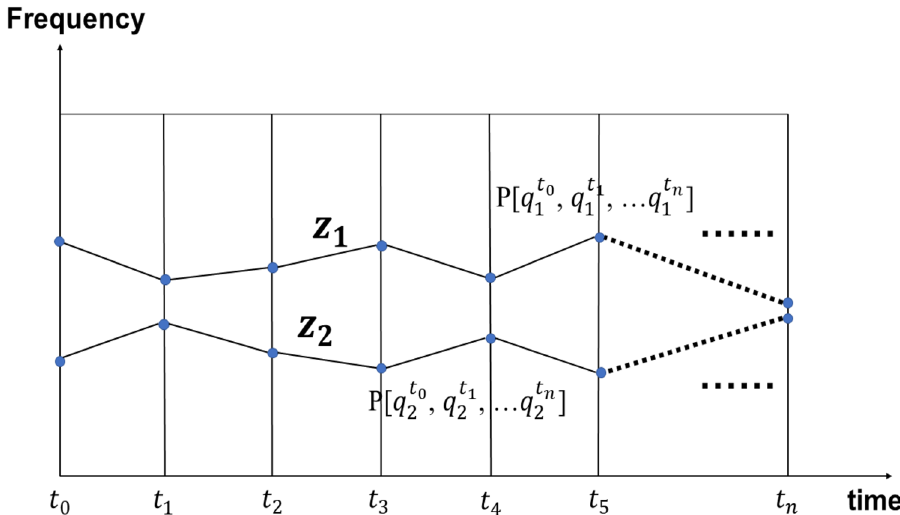
( t ) 1,2 ] whose independent variable is a time ( t ) 1,2 ,]. For the discrete case, the distribution of the probability ] . The path distribution is satisfied q ( t ) + q ( t ) P path [ q ( t 0 ) q ( t 1 ) q ( t 2 ) q ( t n ) 1,2 , 1,2 , 1,2 , … 1,2 2 =1 at each 1